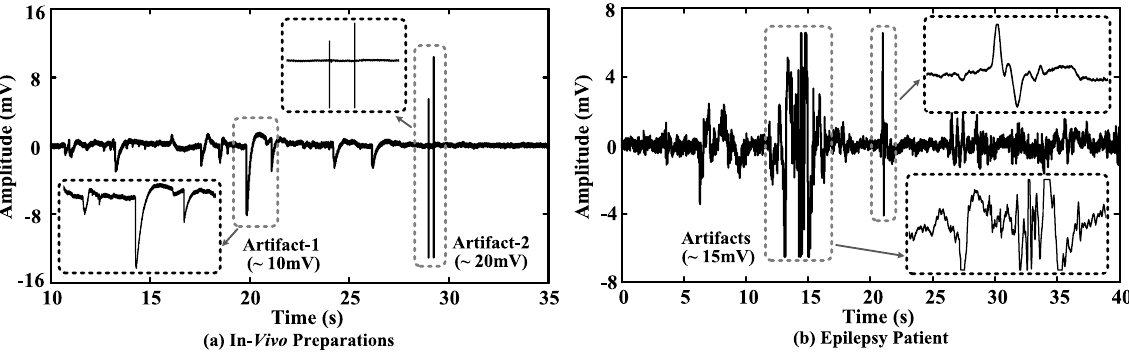
( a ) In vivo neural recording from a rat preparation and ( b ) an intracortical recording from an epilepsy